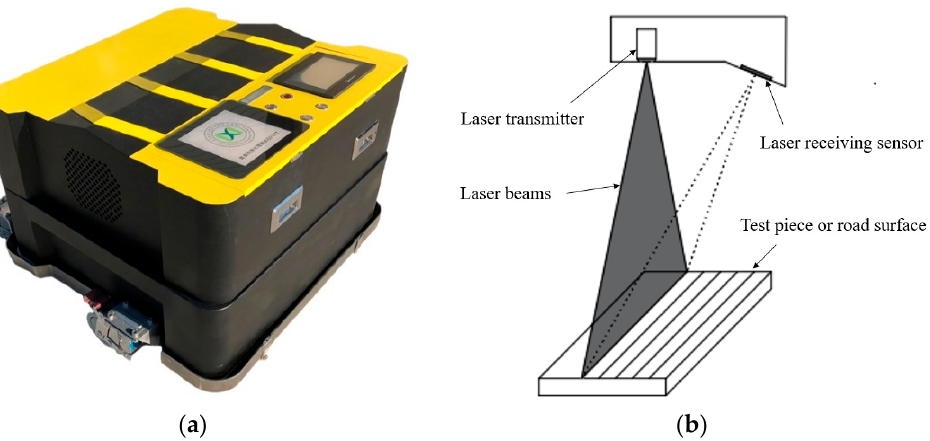
Figure 10. The anti-slip texture tester and the principle of the pavement: ( a ) anti-slip texture tester for road surfaces; ( b ) principle of the road surface anti-slip texture tester. for road surfaces; ( b ) principle of the road surface anti-slip texture